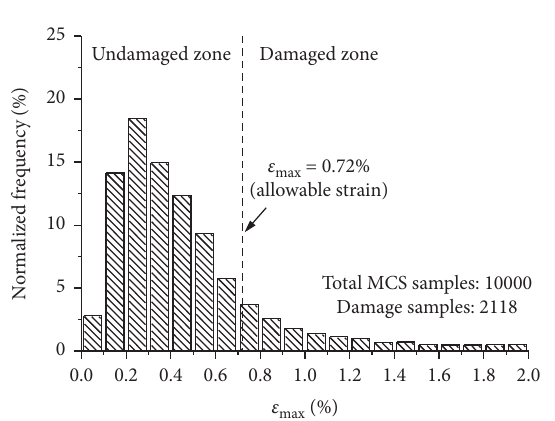
Figure 7: Influence of the number of Monte Carlo simulations on cable damage probability.